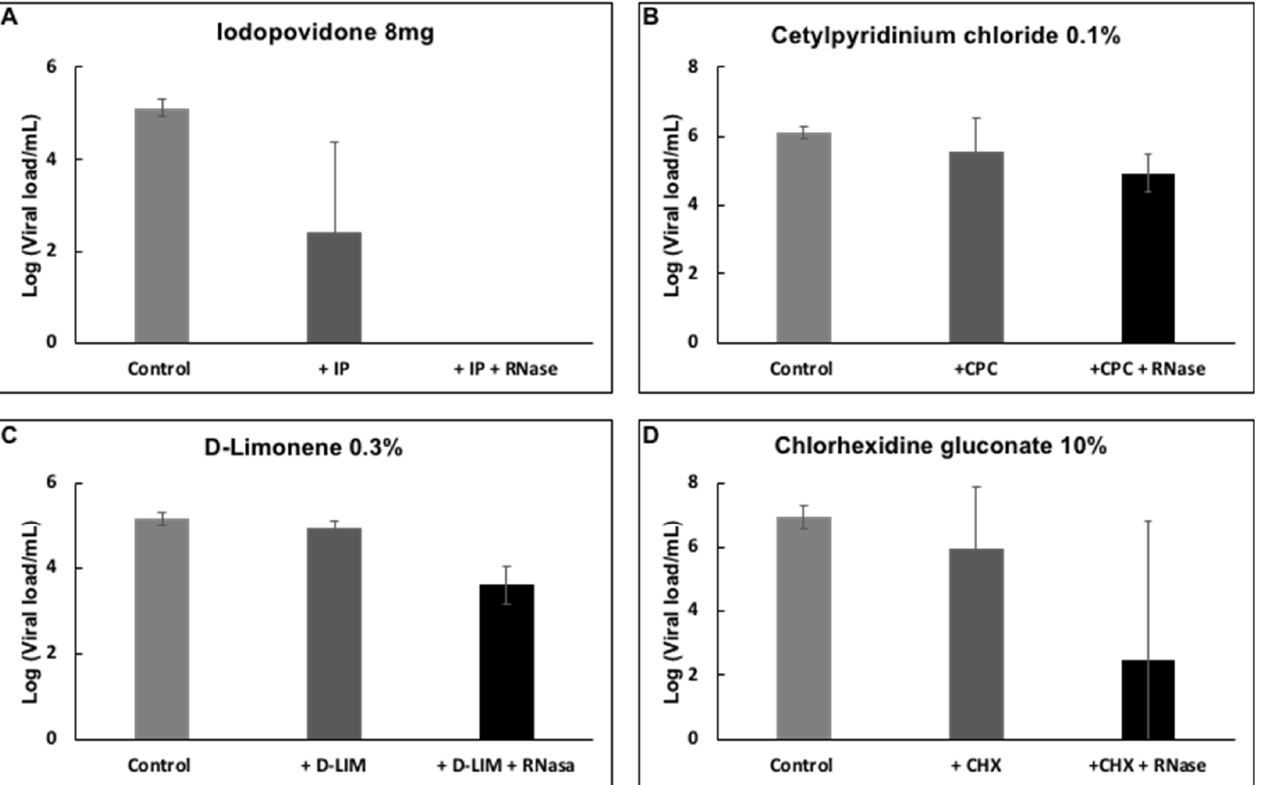
Figure 4. Effect of ( A ) IPV * 4%, ( B ) CPC † 0.1%, ( C ) D-limonene ‡ 10%, and ( D ) CHX § 10% on the detection of SARS-CoV-2 RNA by RT-PCR. Plots show the Mean and SD of 4–5 experiments.